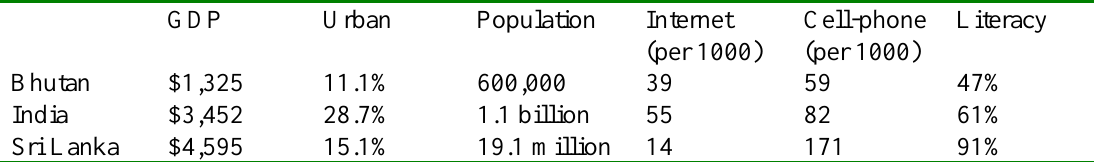
Cell-phone Literacy (per 1000) (per 1000)